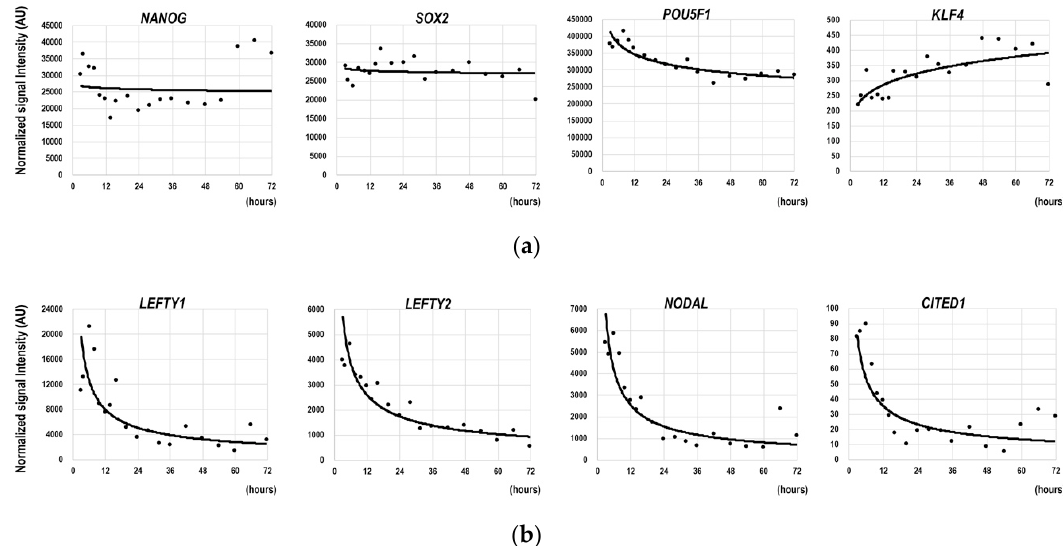
Figure 1. Changes in the gene expression profile in the earliest phase of differentiation. hESCs (KhES-3) were subjected to differentiation into brown adipocytes (BAs). During the time period from 3 h to 72 h after the induction of differentiation, cells were harvested at 19 time points in total and microarray analyses were performed. Horizontal and longitudinal axes indicate hours from the start of differentiation induction and normalized signal values, respectively. Data regarding ( a ) immature pluripotent stem cell marker genes and ( b ) the genes with time-dependent reductions are shown. The power approximate curve is shown on each graph.